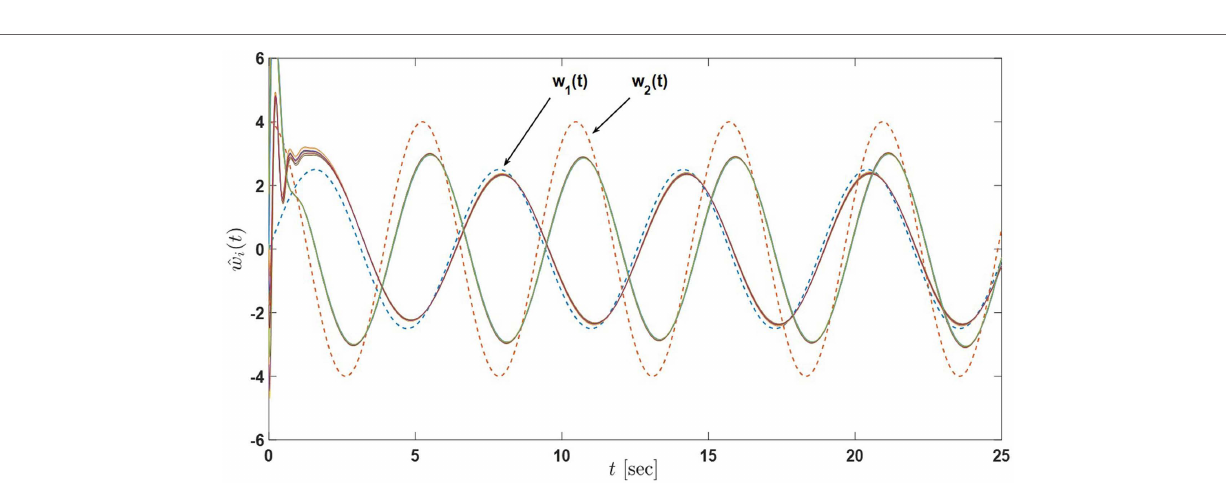
Frontiers in Robotics and AI |